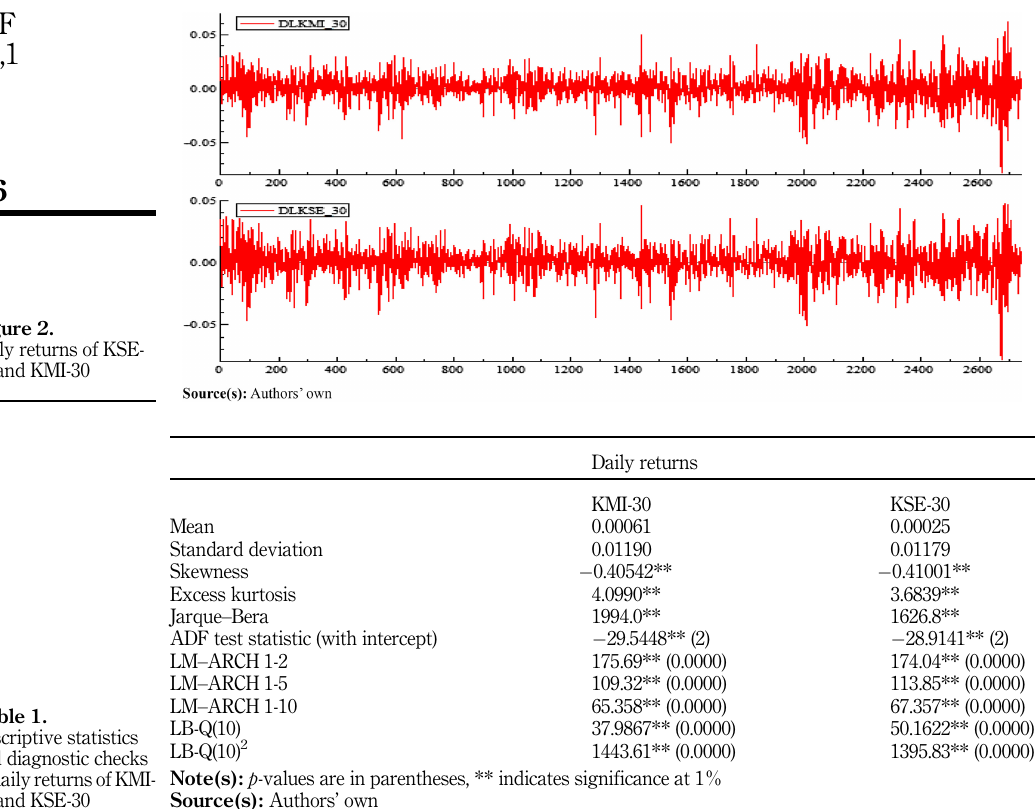
and diagnostic checks ofdailyreturnsofKMI- 30 and